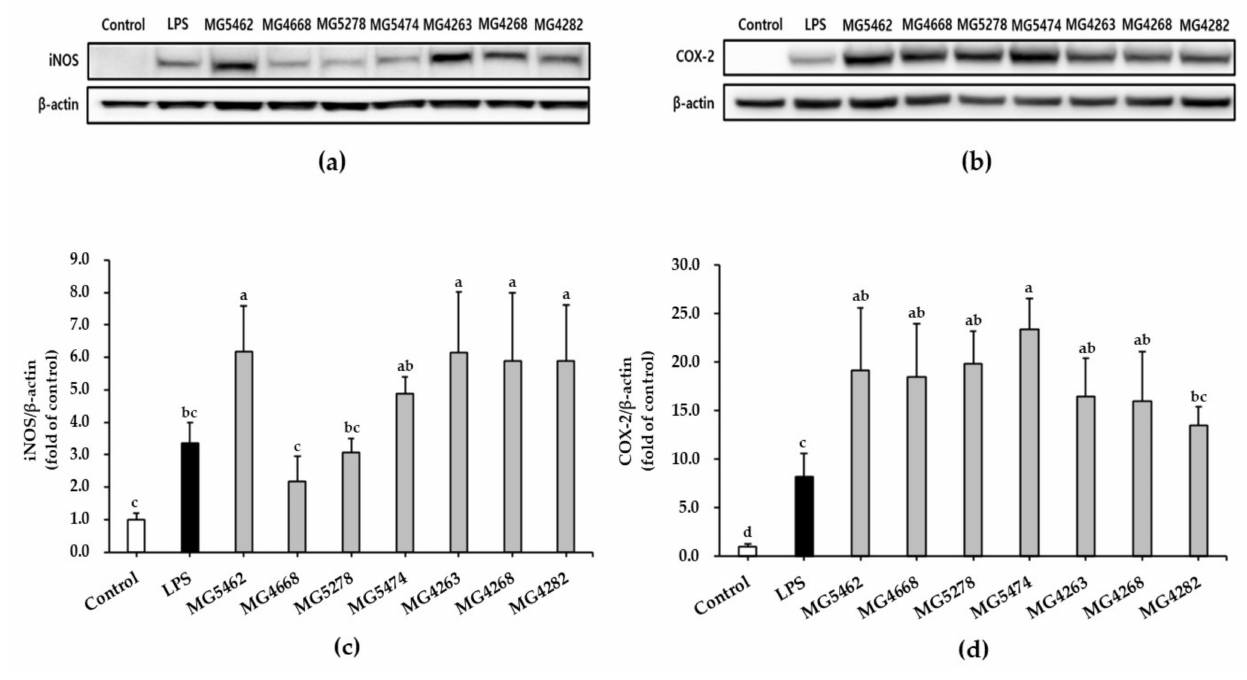
Figure 2. Effect of CFS from LAB strains on the protein expression levels of iNOS and COX-2 in RAW264.7 cells. Representative Western blot and expression of iNOS ( a , c ) and COX-2 ( b , d ). Cells were treated with LPS (10 ng/mL) or CFS (5 mg/mL) for 24 h. The protein expression levels were quantified by densitometry, and the data were normalized relative to the intensity of β -actin. Untreated cells (control) were treated with DMEM only. Data are presented as the mean ± SD of three independent experiments ( n = 3). Different letters indicate significant differences between means at p < 0.05 based on Duncan’s multiple range